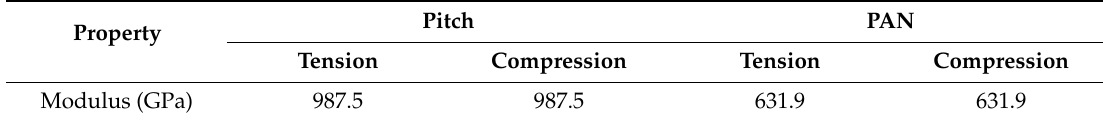
Figure 9. Tensile and compressive multiscale simulation results of baseline (no damage) properties for PAN and pitch-based single carbon fibers. Table 2. Summary of modulus results from Figure 9.